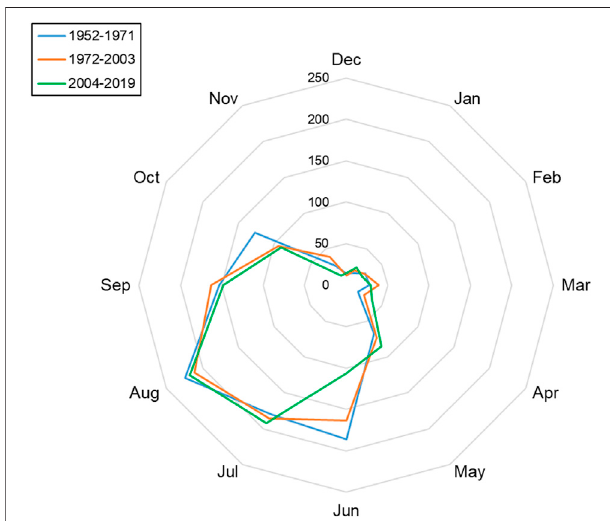
FIGURE 7 | Radar chart for monthly precipitation (mm) in Erhai Lake catchment in 1952 – 1971, 1972 – 2003, and 2004 – 2019 periods.